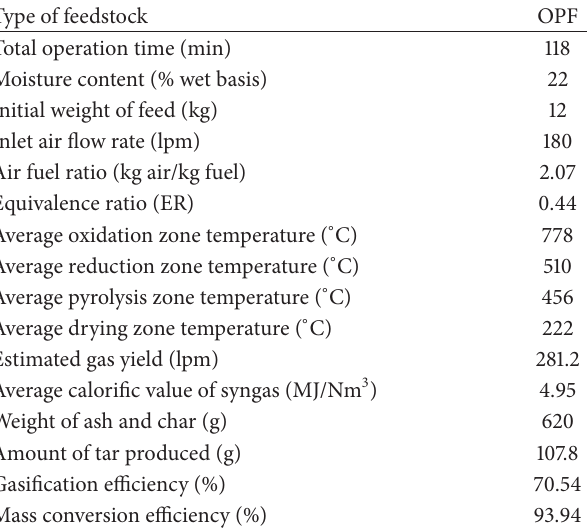
Table 2: Operation parameters and results for a typical gasification test operation.